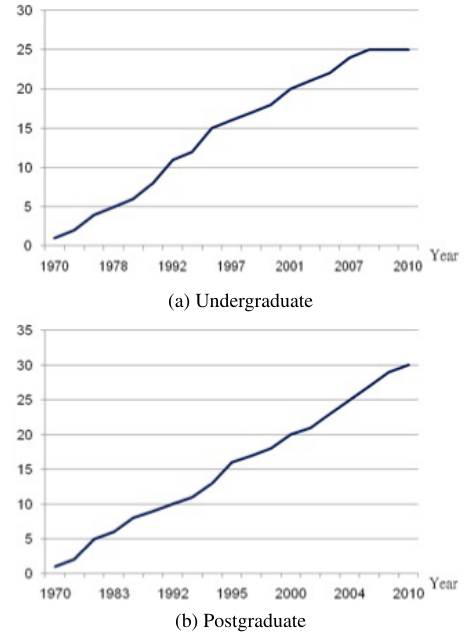
Figure 2: Number of departments offering geospatial